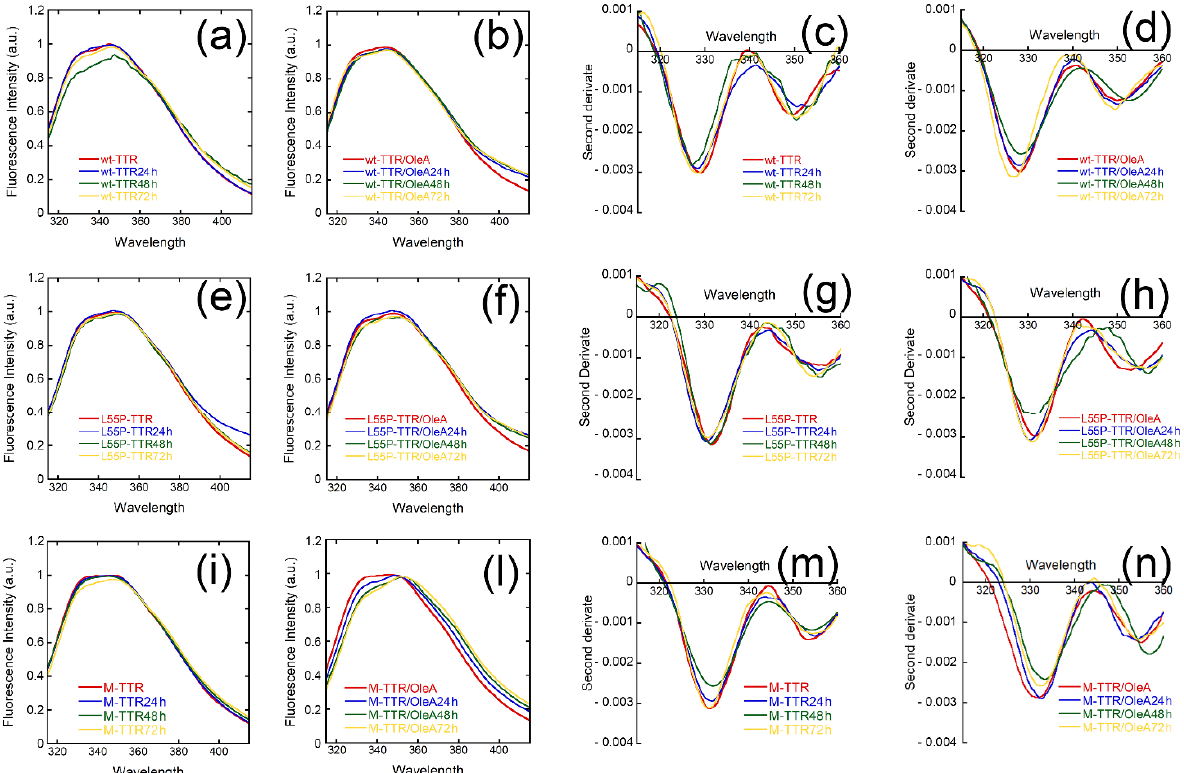
Figure 7. Intrinsic fluorescence emission spectra recorded at different times of incubation of wt-TTR ( a ), L55P-TTR ( e ), and M-TTR ( i ) before and after OleA supplementation to the incubation mixture ( b , f , l ). The spectra were normalized to fluorescence intensity of 1.0 at λ max , λ exc = 295 nm. ( c , d , g , h , m , n ). The second derivatives were obtained from the previous emission spectra.